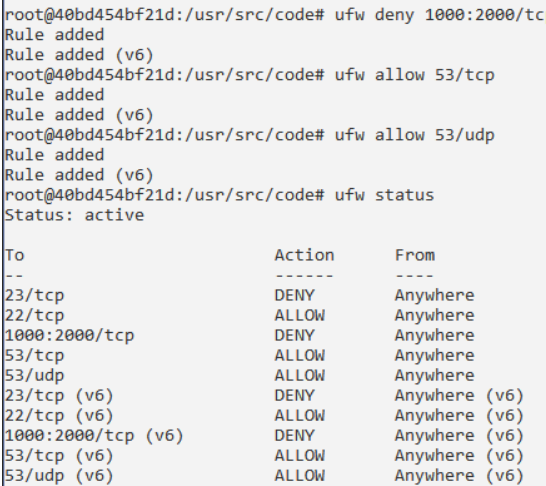
Figure 7. Working with the